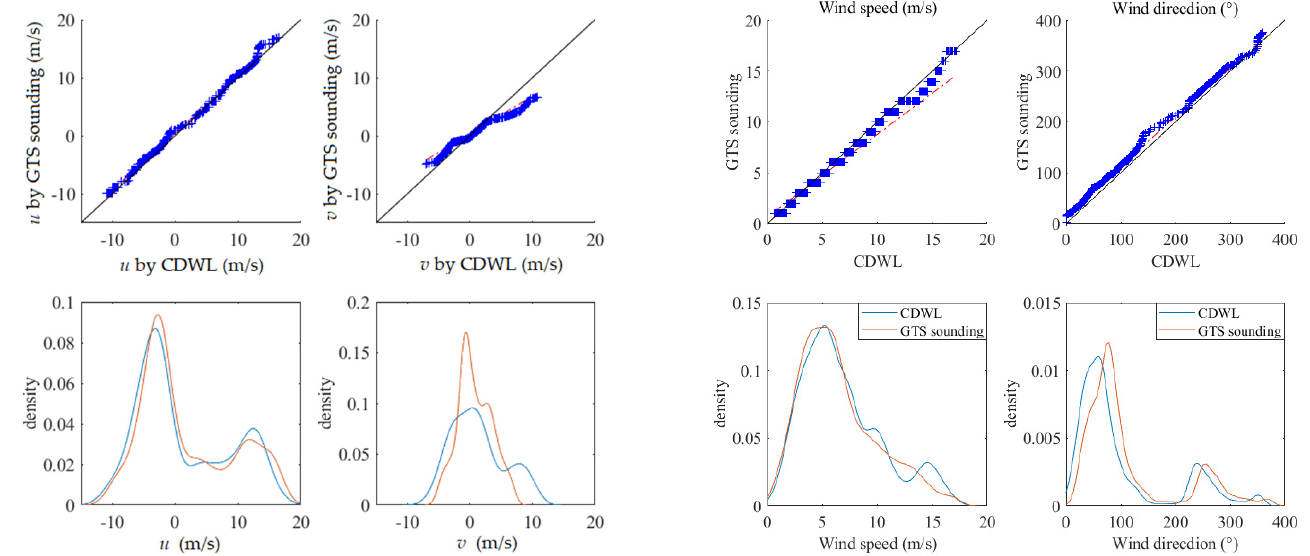
Figure 4. Quantile-quantile plot and probability density distribution of u and v wind fields and wind direction and speed from CDWL and GTS soundings’ observations. The regression line (red line) and reference line y = x (black line) are also shown.